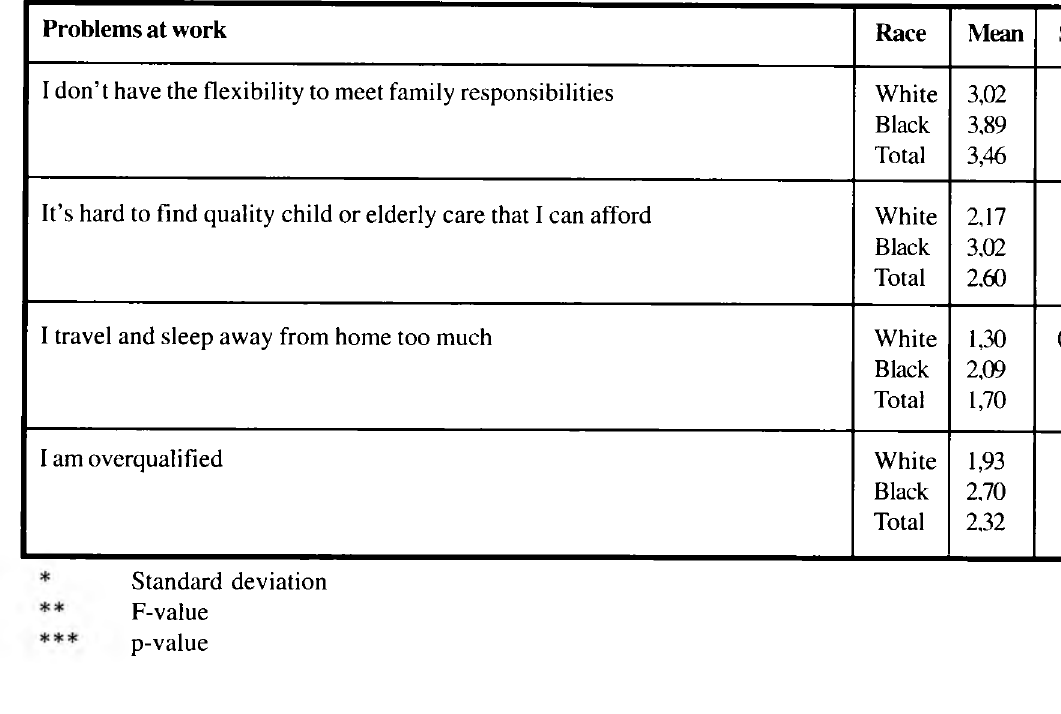
Table 4 How the different educational groups compare with regard to problems at work Problems at